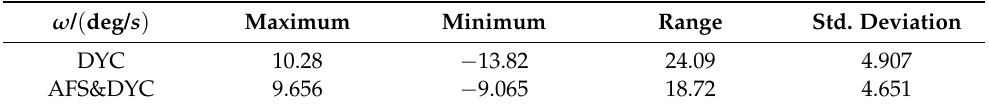
Table 6. Yaw rate under low adhesion coefficient.